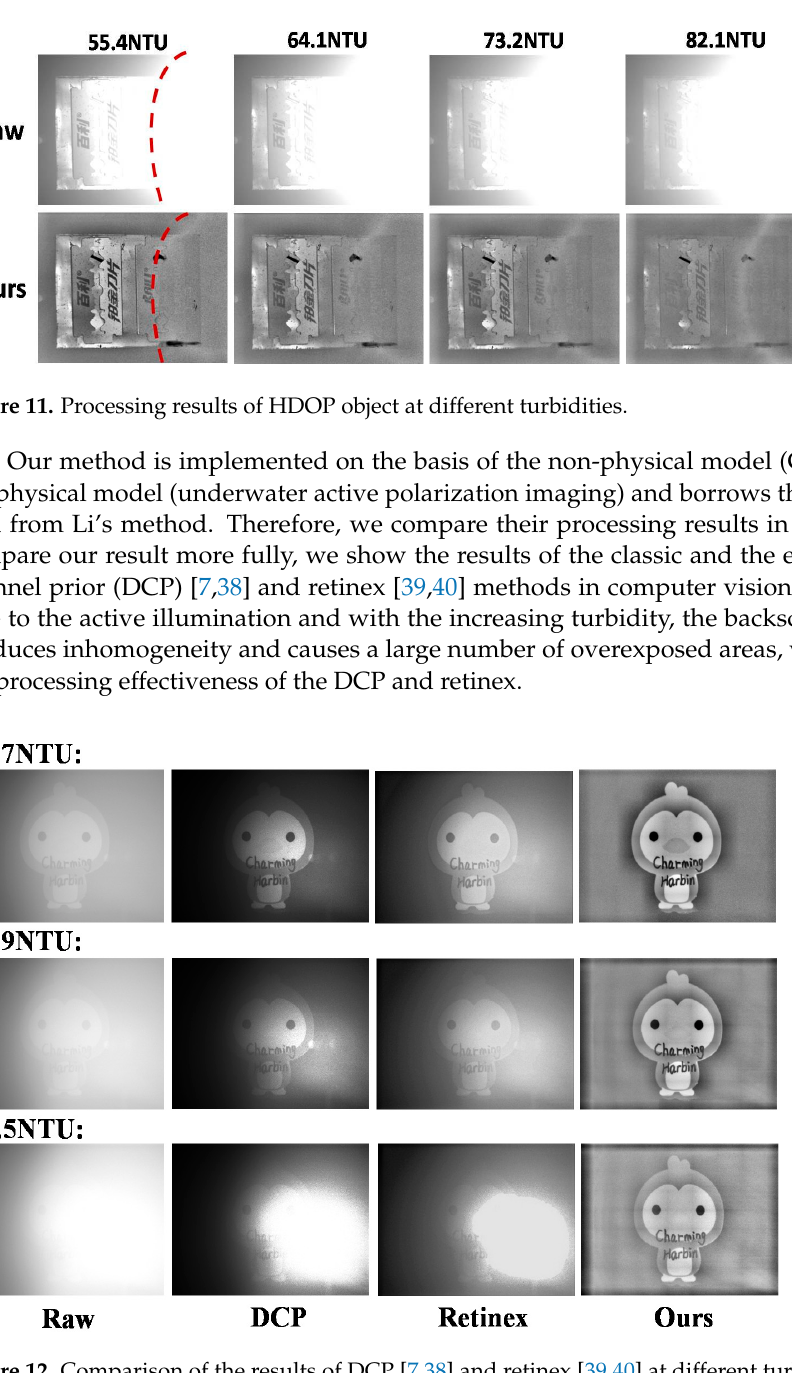
Figure 11. Processing results of HDOP object at different turbidities.